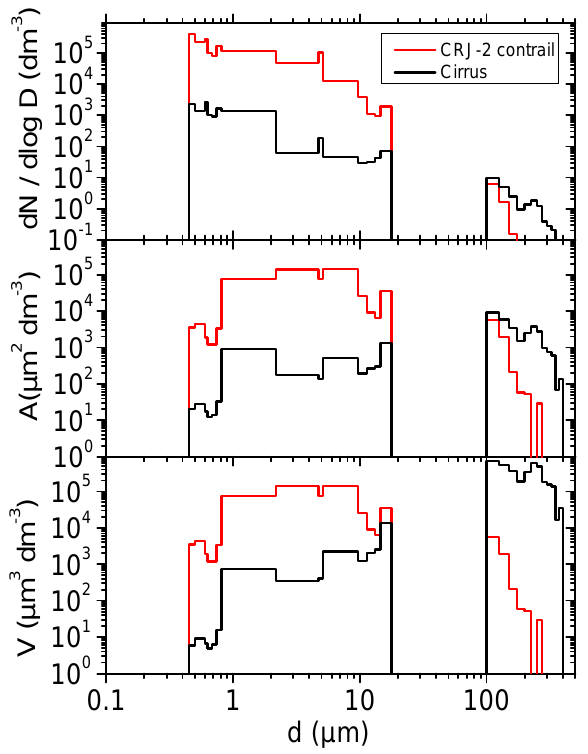
Fig. 10. Particle size, surface and volume distributions of the CRJ-2 contrail (red) embedded in a cirrus cloud (black). The ice surface area (ice volume) is given inµm 2 dm − 3 air (µm 3 dm − 3 air) for each size bin. The total ice surface area and total ice volume can be calculated by summing up the individual size